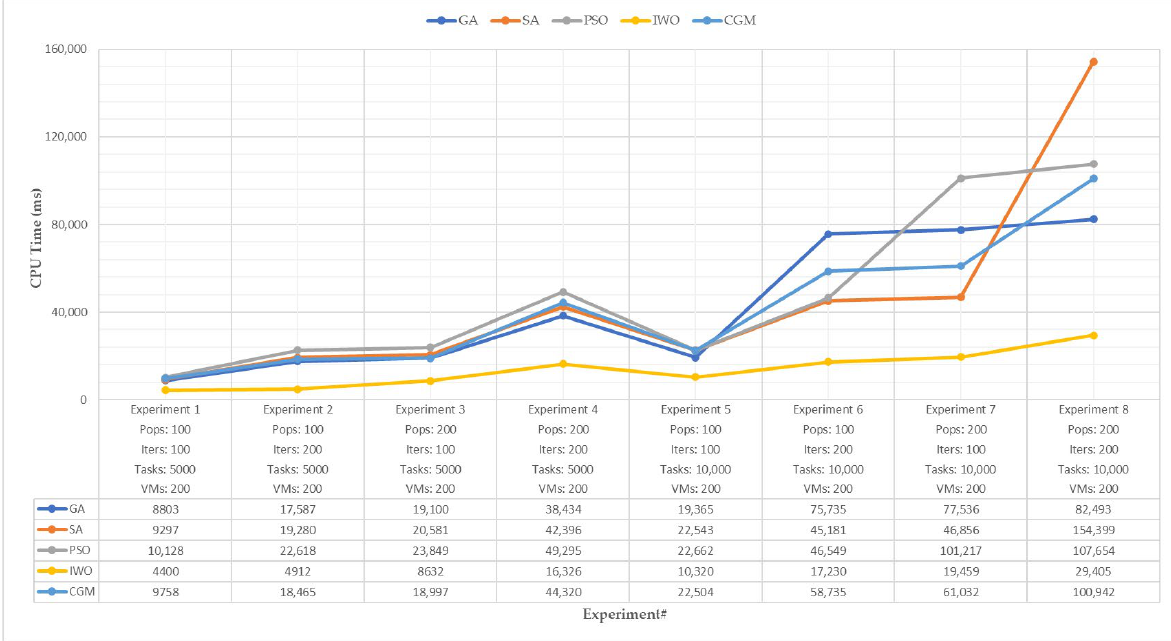
Figure 20. Evaluation results of execution time (CPU time) criterion for the traveling salesman problem with large parameters (in milliseconds).